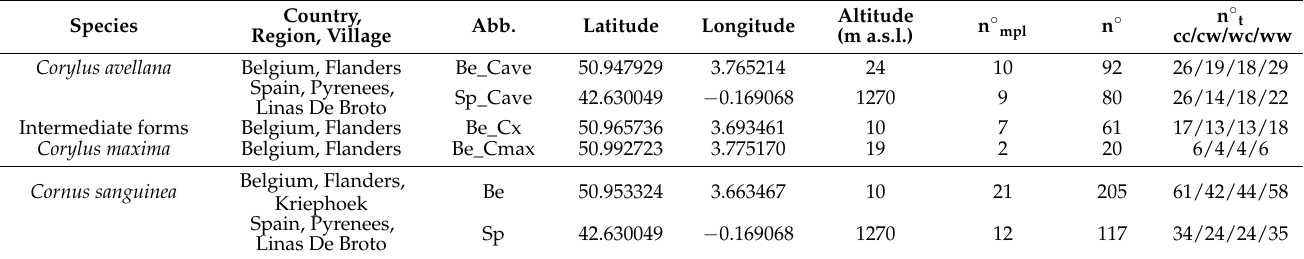
Table 1. Description of the sampling sites and details on the seedlings of the Corylus taxa and Cornus sanguinea . Abb.: abbreviation of the provenance, including an abbreviation of the taxon for Corylus; n ◦ mpl : number of mother plants; n ◦ : number of seedlings; n ◦ t cc/cw/wc/ww: number of seedlings conforming with the spring treatment (first letter) and the summer–autumn treatment (last letter) of 2018, with cc: cold–cold, cw: cold–warm, wc: warm–cold, and ww: